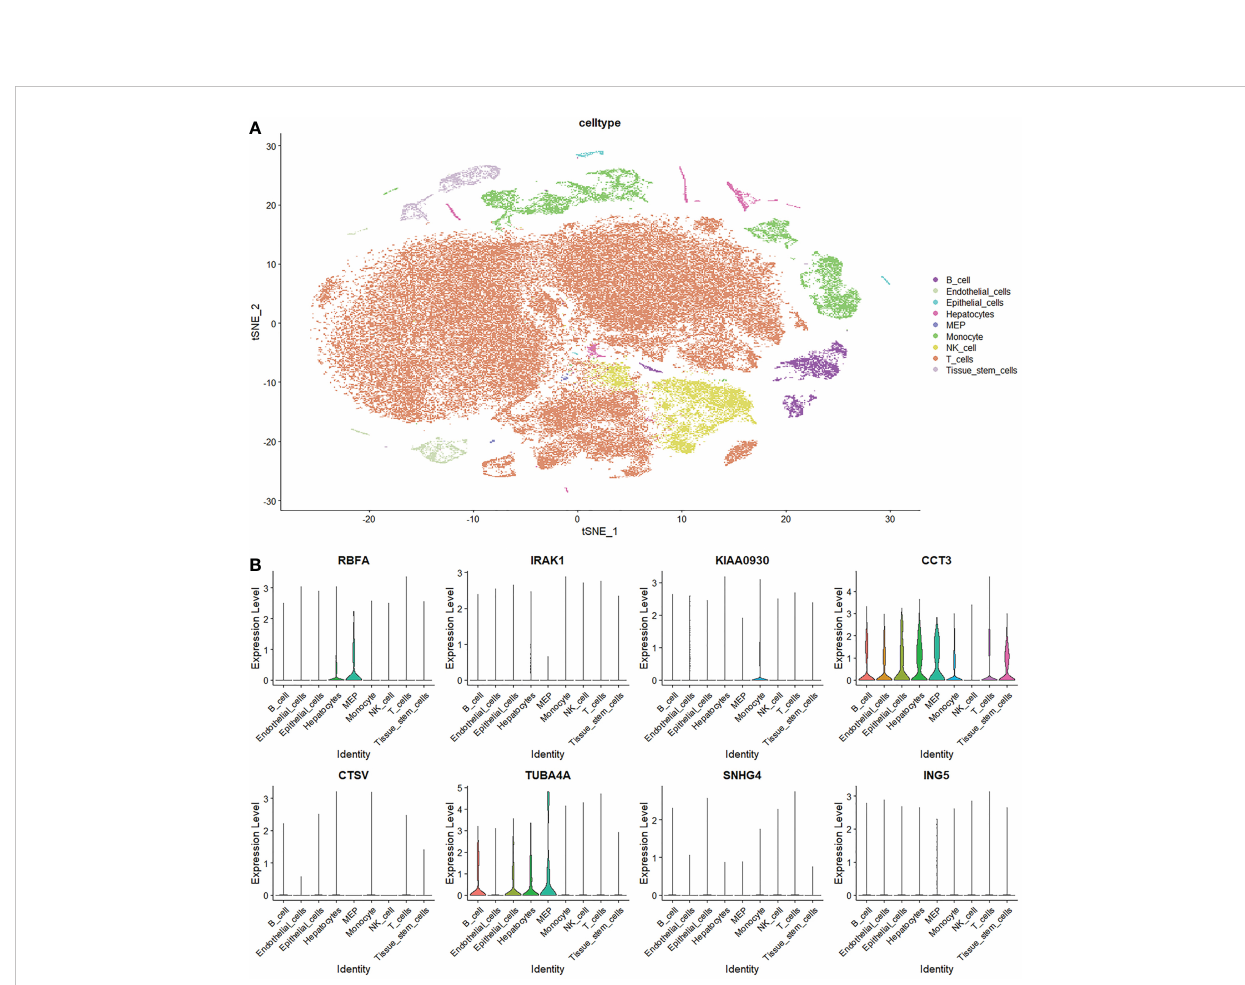
FIGURE 13 Single-cell analysis of macrophages M0-related genes. (A) Annotation of cell subclusters in the tumor microenvironment of LIHC. (B) Expression pattern of MRGs in the tumor